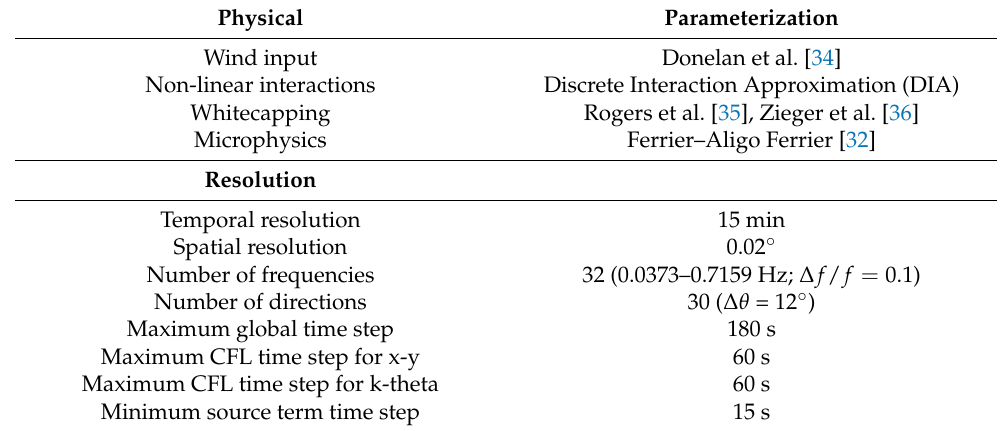
Table 3. Physical processes parameterizations and some resolution characteristics used in the imple- mentation of the atmospheric model WW3 version 6.07 (ST6 according to the model nomenclature).